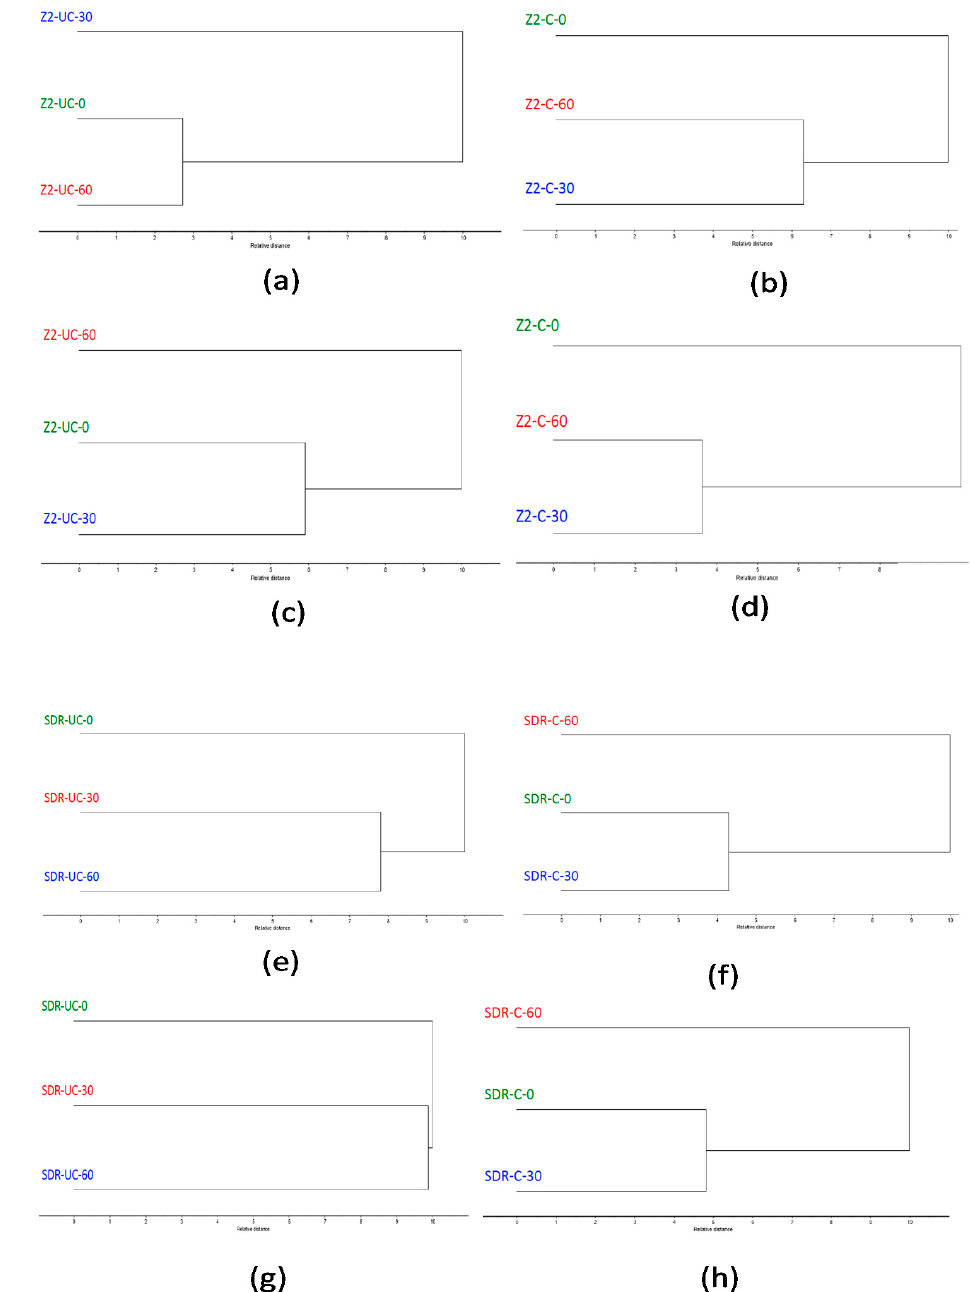
Figure 7. Cluster analysis of Filtek Z250 composite showing uncured and cured at spectral range 1590–1650 cm − 1 ( a , b ), uncured and cured at spectral range 1700–1750 cm − 1 ( c , d ). Cluster analysis of SDR composite showing uncured and cured at spectral range 1590–1650 cm − 1 ( e , f ), uncured and cured at spectral range 1700–1750 cm − 1 ( g , h ). At both the spectral ranges, there was a distinct separation without ultrasonic treatment from 30 s and 60 s while in the uncured state. However, once cured, control was branched closer to the 30 s treated